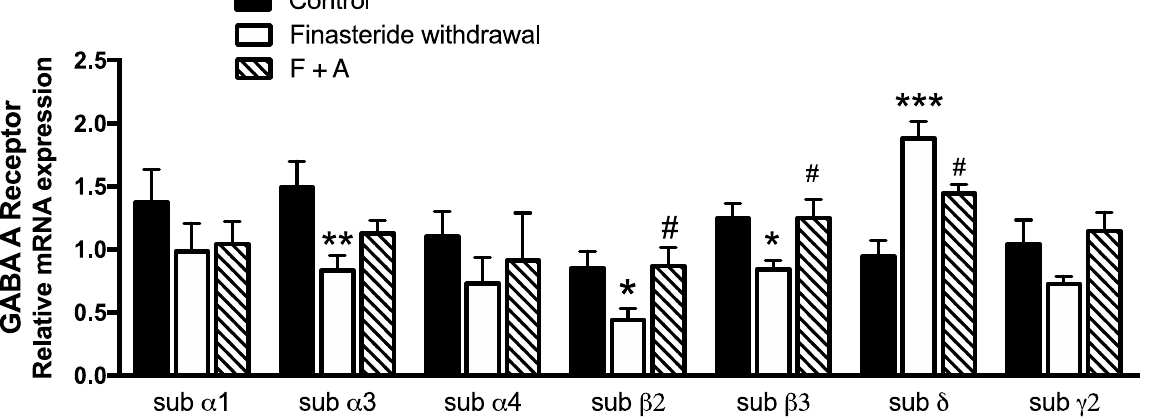
Figure 5. Gene expression of GABA-A receptor subunits α 1, α 3, α 4, β 2, β 3, δ and γ 2 in the colon of controls, finasteride-treated rats and ALLO-treated rats after drug withdrawal. The columns represent the mean ± SEM after normalization with 36B4 mRNA, n = 7 for each group. The effect of treatment of ALLO was analyzed using one-way ANOVA followed by Uncorrected Fisher’s LSD post hoc test (significance: * p < 0.05, ** p < 0.01, *** p < 0.001 vs. control group; # p < 0.05 vs. finasteride-treated rats).